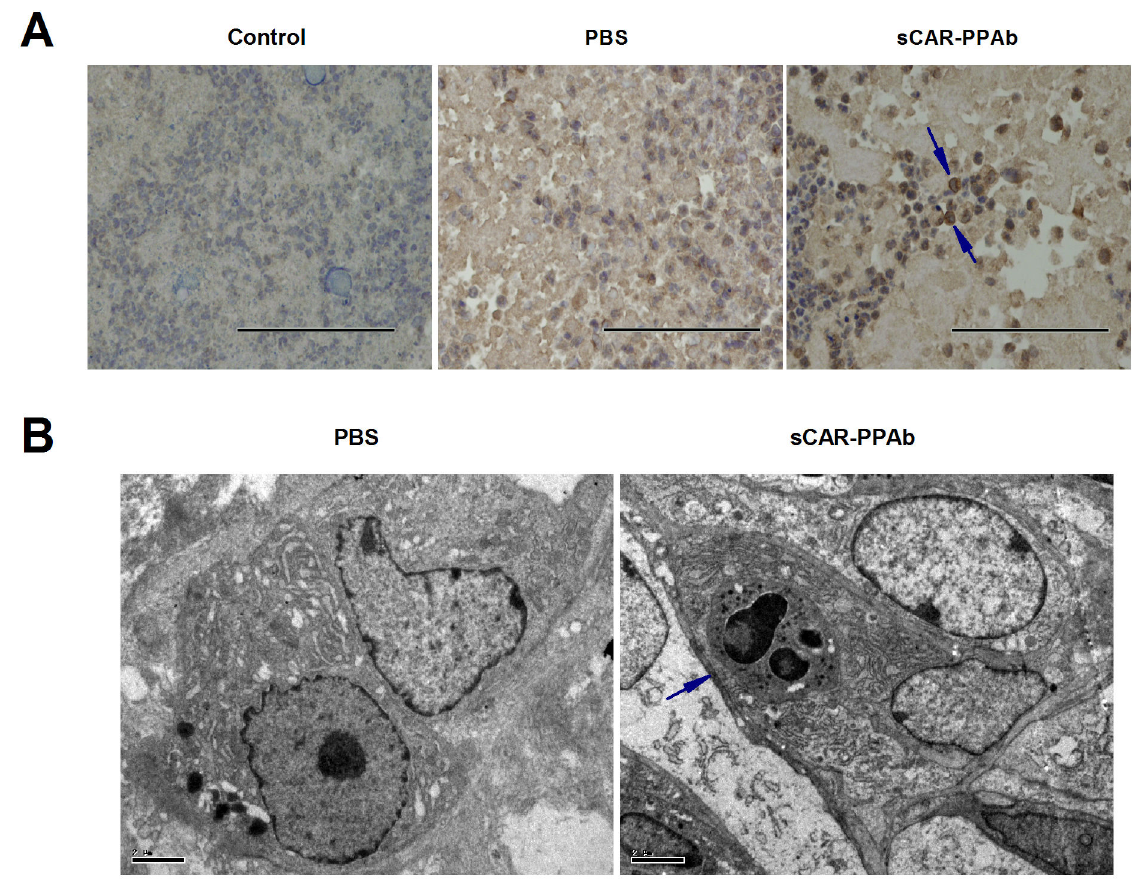
Figure 3. sCAR-PPAb activated macrophages in a K562/ADR xenograft model. BALB/c nude mice were transplanted with K562/ADR cells subcutaneously. sCAR-PPAb were injected intratumorally for 7 days at 100μg/day. PBS injection served as the control. A. Tumors were harvested and F4/80 was analyzed for macrophage infiltration by immunohistochemistry. The control showed IgG isotype staining. Arrows point to cells stained with F4/80. Bars show 200μm (400 x). B. Tumors were analyzed using a transmission electron microscope. The arrow points to cells undergoing phagocytosis. Bars show